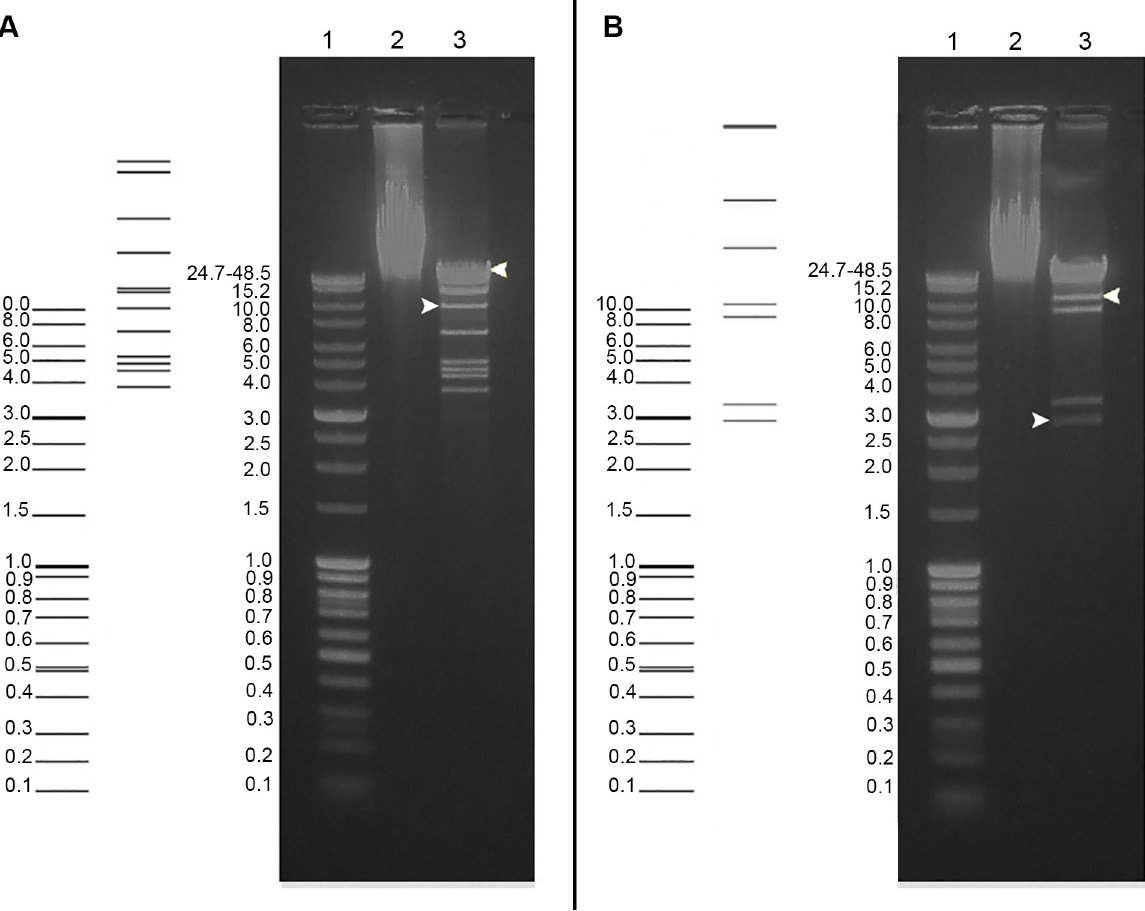
Fig 2. Phage DNA digested with restriction endonucleases PacI (A) and AfeI (B) in silico and in vitro (the left and right side of each image, respectively). Lanes (for each image): 1 –molecular weight markers (SibEnzyme, mix of Cat.# M29 and M33), 2 –intact phage DNA, 3 –digested DNA. The lengths of the fragments predicted for PacI: 33909, 32075, 24289, 18753, 13056, 12356, 9779, 6893, 4963, 4570, 4274, 3721; for AfeI: 54176, 40885, 27581, 19892, 10860, 8996, 3337, 2920. Terminal fragments are underlined here in the text and indicated by the arrows on the